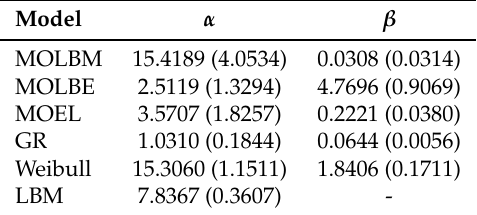
Table 11. Estimates and standard errors (in parentheses) of the parameters for Data set 3.